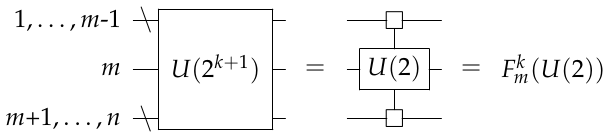
Figure 2. A multi-controlled U (2) gate.